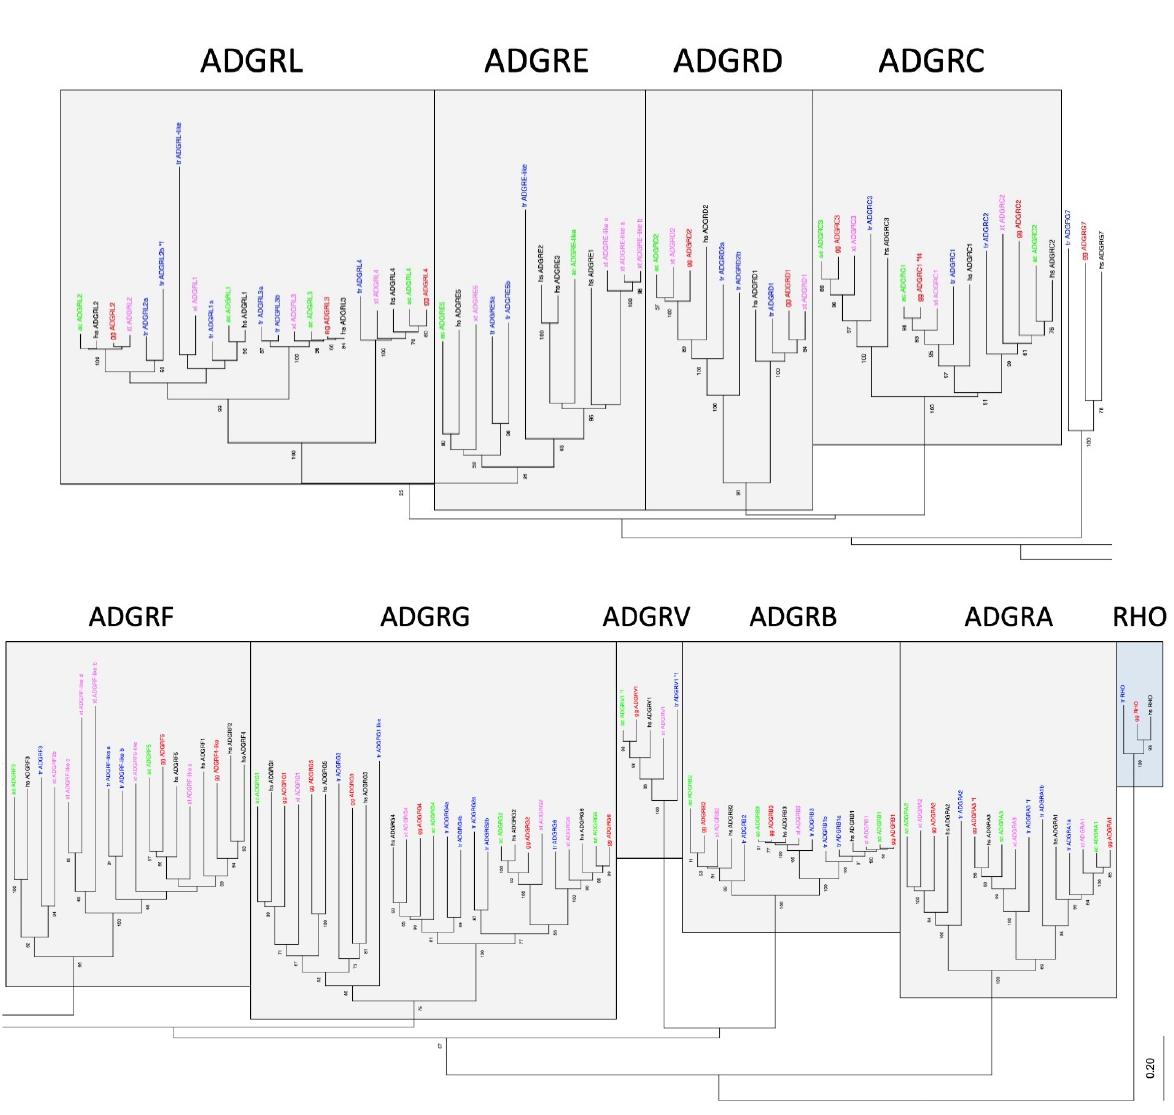
Figure 2. Phylogeny of representative vertebrate aGPCRs. The 7TM amino acid sequence of orthologs of all aGPCR families from human (black, hs: Homo sapiens ), chicken (red, gg: Gallus gallus ), lizard (green, ac: Anolis carolinensis ), frog (magenta, xt: Xenopus tropicalis ), and bony fish (blue, tr: Takifugu rubripes ) were aligned using MUSCLE. A Neighbor-Joining tree (NJ) was generated using rhodopsin orthologs from fish, bird, and human as outgroup. The tree was split for better visibility and the currently assigned nine aGPCR families are individually boxed [19]. The percentage of replicate trees in which the associated taxa clustered together in the bootstrap test (100 replicates) are shown next to the branches [32]. The fully resolved NJ and ML trees with bootstrap test (1000 replicates) are given in Suppl. Figure S3. The accession numbers are given in Suppl. Table S1, * f, only sequence fragments were found in the databases.